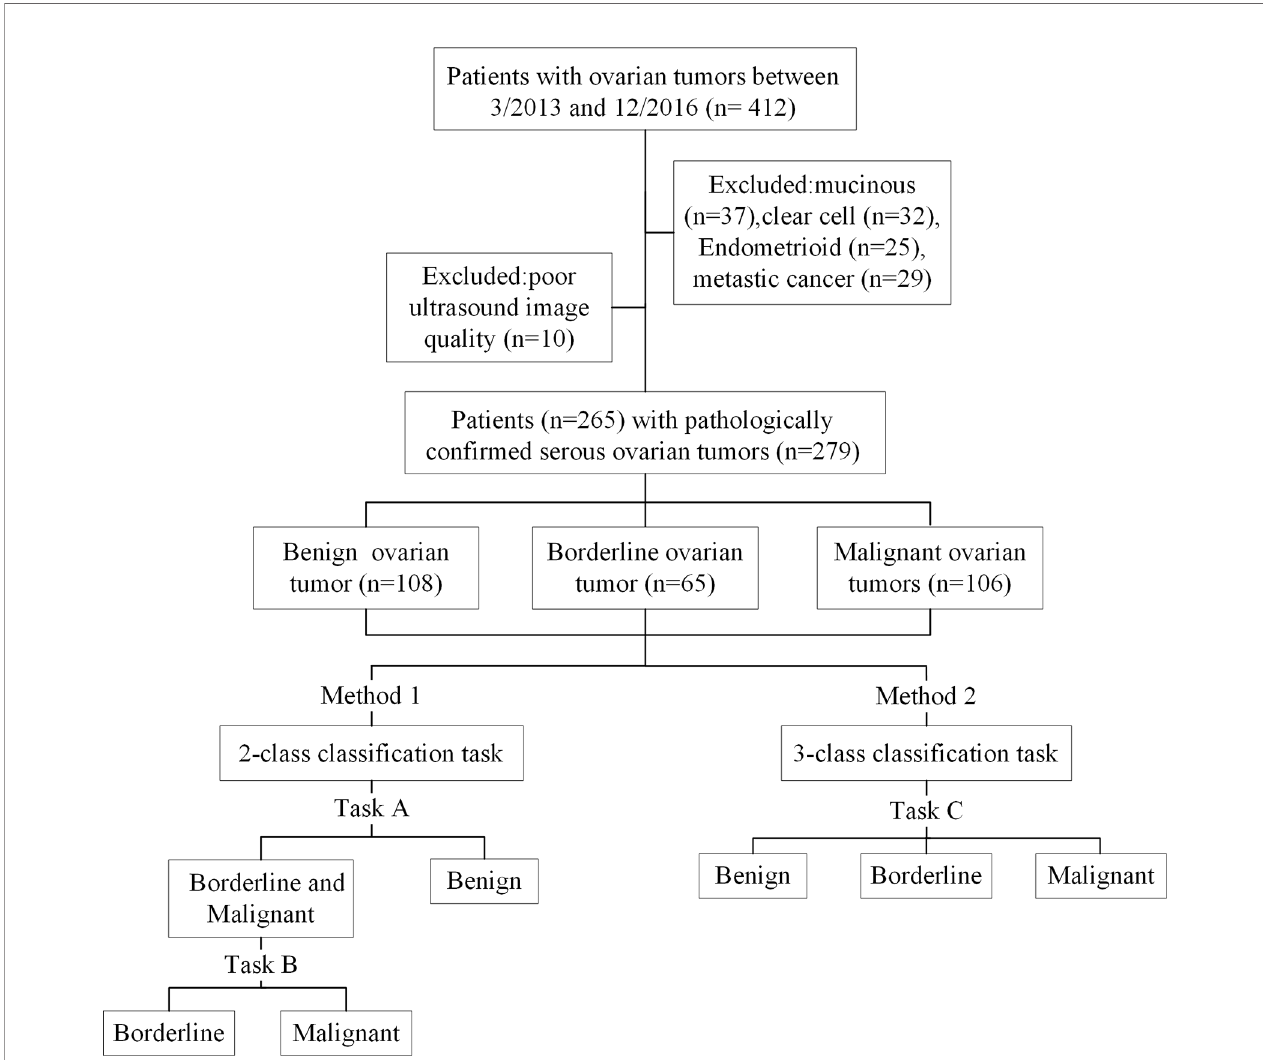
FIGURE 1 | Flowchart of patient recruitment and the experimental design.